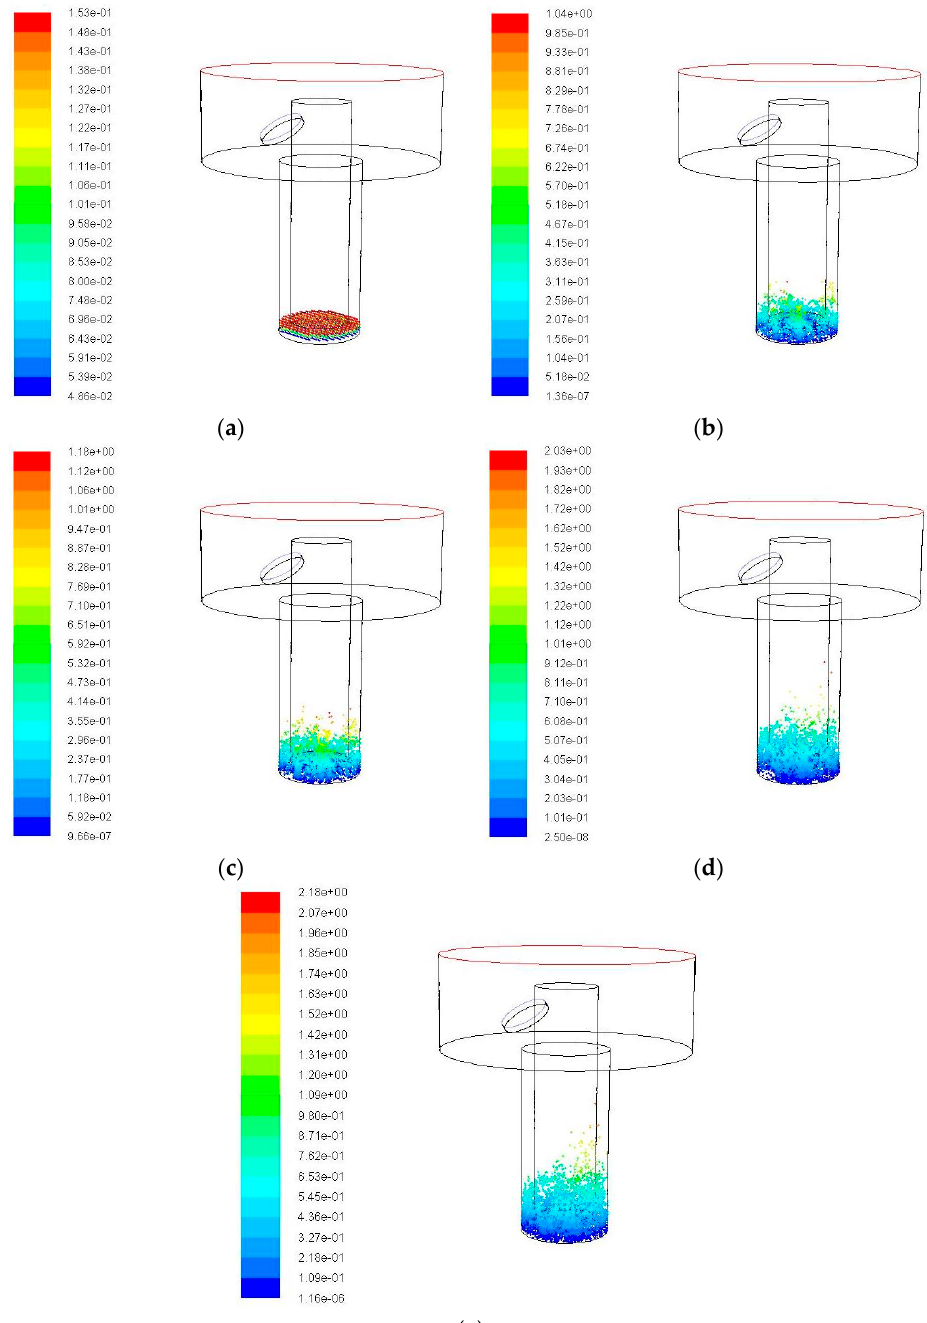
Figure 9. The debris movement with time when ultrasonic frequency is 30 kHz, amplitude is 5 μ m. ( a ) Initial debris distribution; ( b ) Debris distribution at 0.01 s; ( c ) Debris distribution at 0.02 s; ( d ) Debris distribution at 0.03 s; and, ( e ) Debris distribution at 0.04 s.